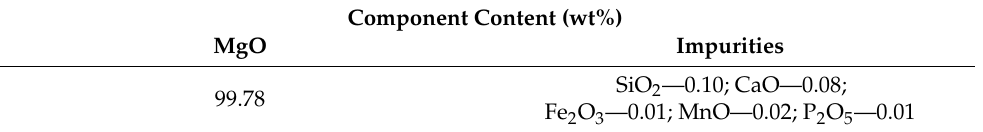
Table 2. Chemical composition of calcined MgO.